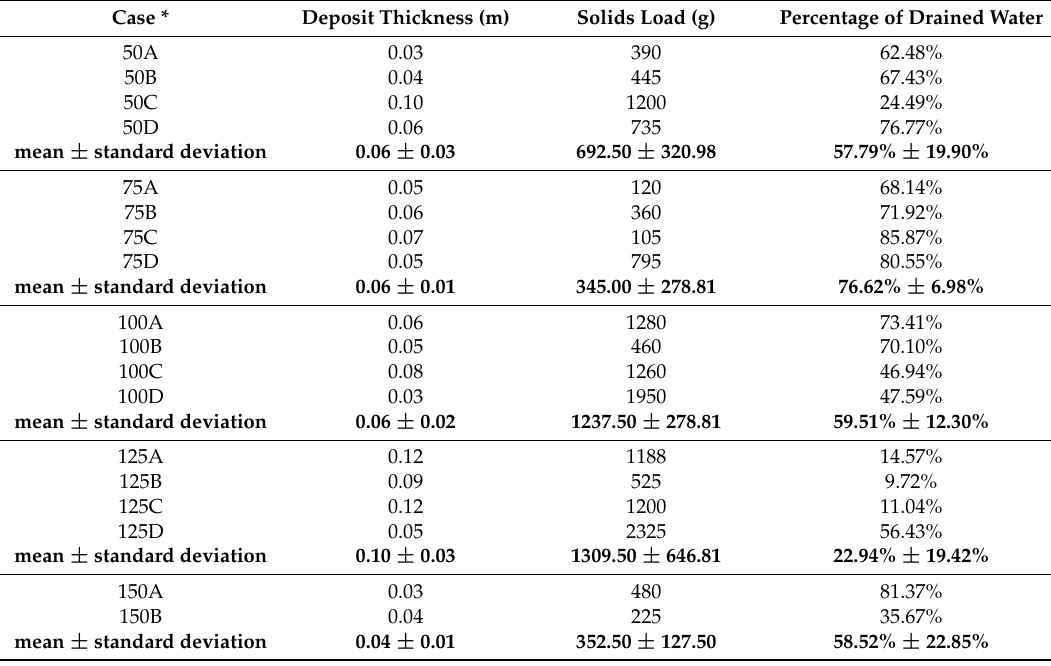
Table 3. Dewatering efficiency in Phase II of the